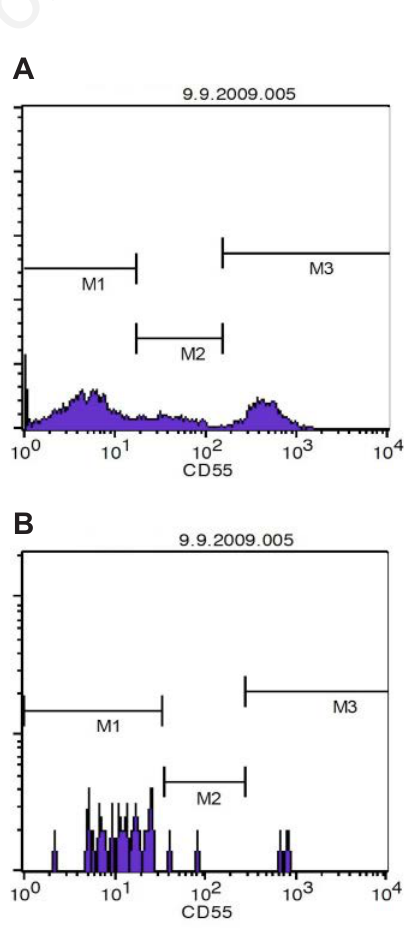
Figure 1. Flow cytometry CD55-based assay for PNH granulocytes (A) and mono- cytes (B). The flow cytometric analysis reveals the presence of an intermediate peak, which testifies to the existence of a second clone